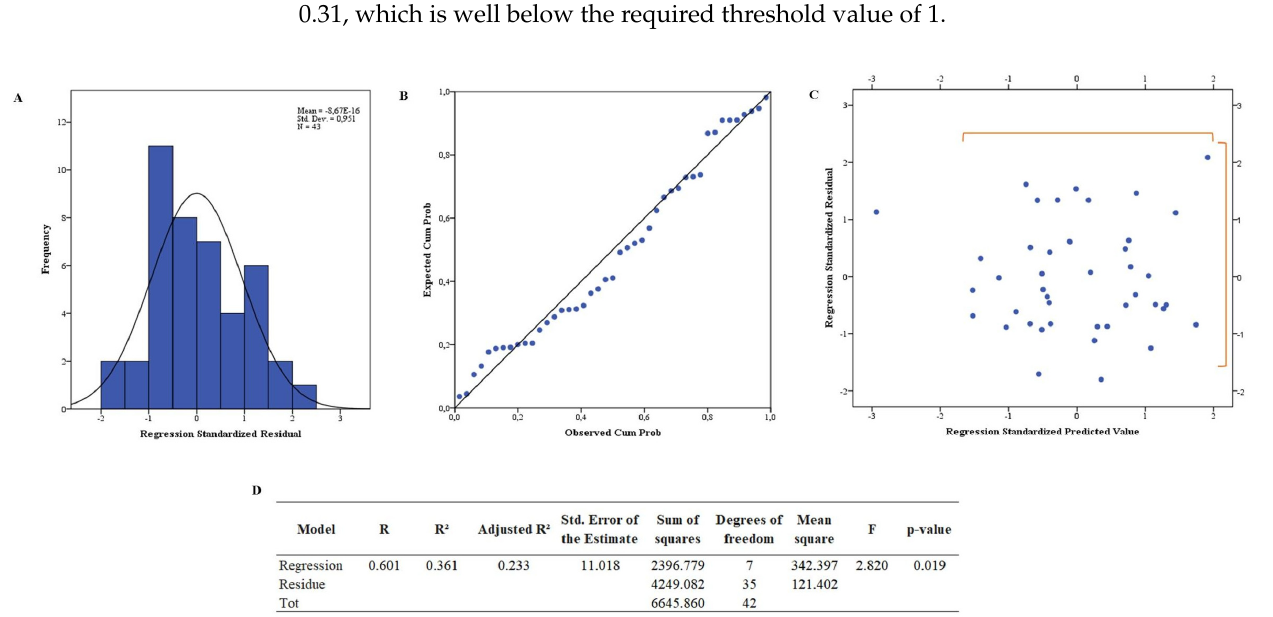
Figure 2. Gaussian distribution ( A ), normal P–P plot of standardized residual ( B ), plot of “standardized residuals” against the “standardized predicted value” ( C ), model summary and Fisher’s exact test ( D ) of the final model.